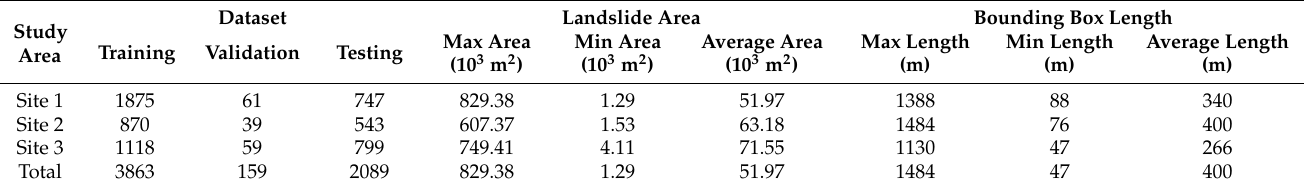
Table 1. Datasets of Landslide